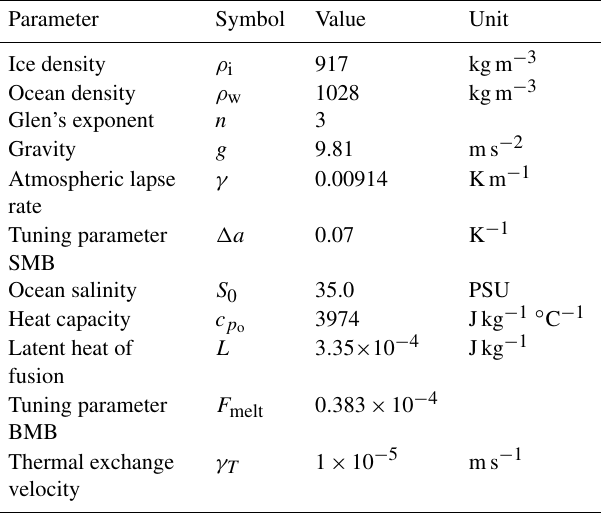
Table 1. Numerical values of the parameters adopted for the simu- lations.